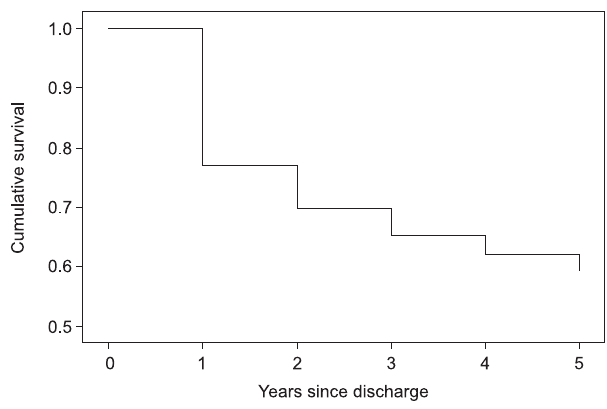
Figure 1 - Cumulative survival rate for the study cohort within five years after